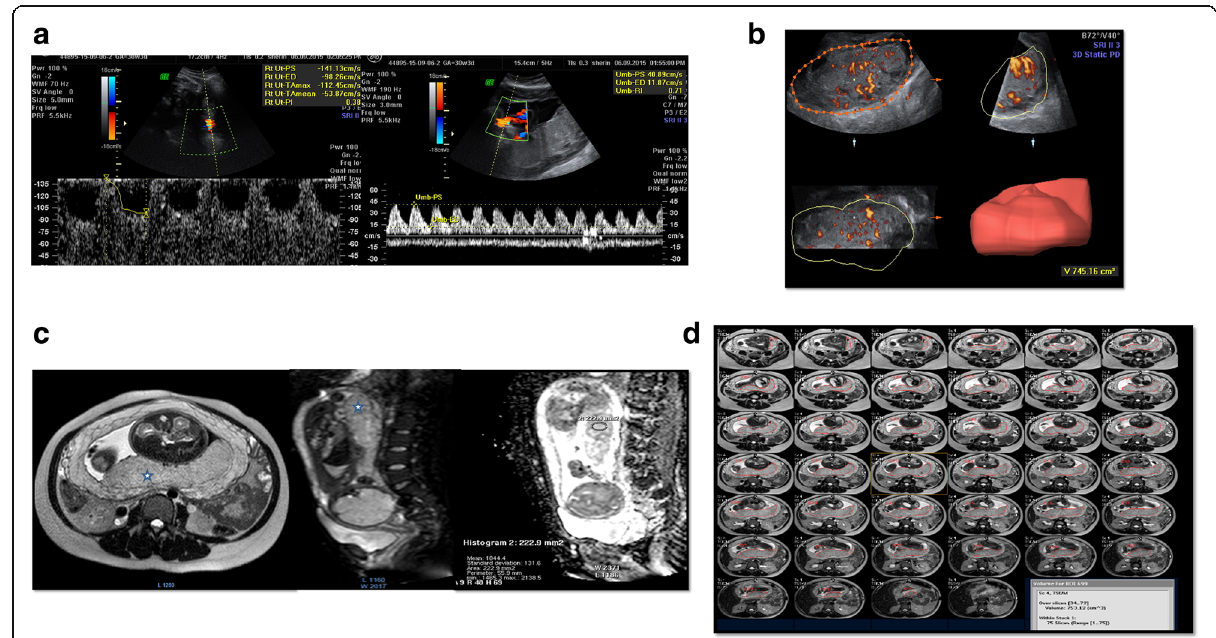
Fig. 2 Pregnant female, 19 years old. She did not have any medical problems with her pregnancy. Her obstetric code was G1P0. Gestational age: 30 weeks + 3 days. a Doppler examination of the uterine and umbilical arteries showed normal RI. b Volume assessment of the placenta by 3D ultrasound: 745. 16 cm 3 . c From right to left, (i) axial T2-weighted image, (ii) sagittal DWI at b 850, and (iii) ADC map that showed average thickness and homogenous texture of the placenta with no abnormal signal noted. ADC value equals 1.84 × 10 – 3 mm 2 /s. d Volume measurement of the placenta by MRI (752.12 cm 3 ). Comments: Both 3D ultrasound and MR showed normal findings and comparable volume measurement of the placenta. She had normal vaginal delivery and average-weighted viable fetus